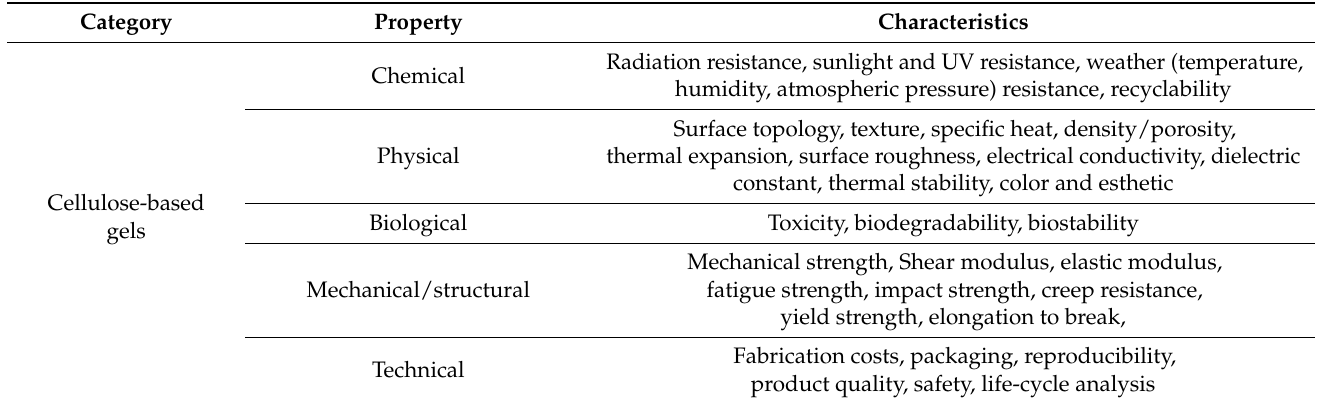
Table 1. Properties/characteristics of the final produced aerogels and hydrogels. Category Property Characteristics Radiation resistance, sunlight and UV resistance, weather (temperature, Chemical humidity, atmospheric pressure) resistance, recyclability Surface topology, texture, specific heat, density/porosity, Physical thermal expansion, surface roughness, electrical conductivity, dielectric constant, thermal stability, color and esthetic Cellulose-based Biological Toxicity, biodegradability, biostability gels Mechanical strength, Shear modulus, elastic modulus, Mechanical/structural fatigue strength, impact strength, creep resistance, yield strength, elongation to break, Fabrication costs, packaging, reproducibility, Technical product quality, safety, life-cycle